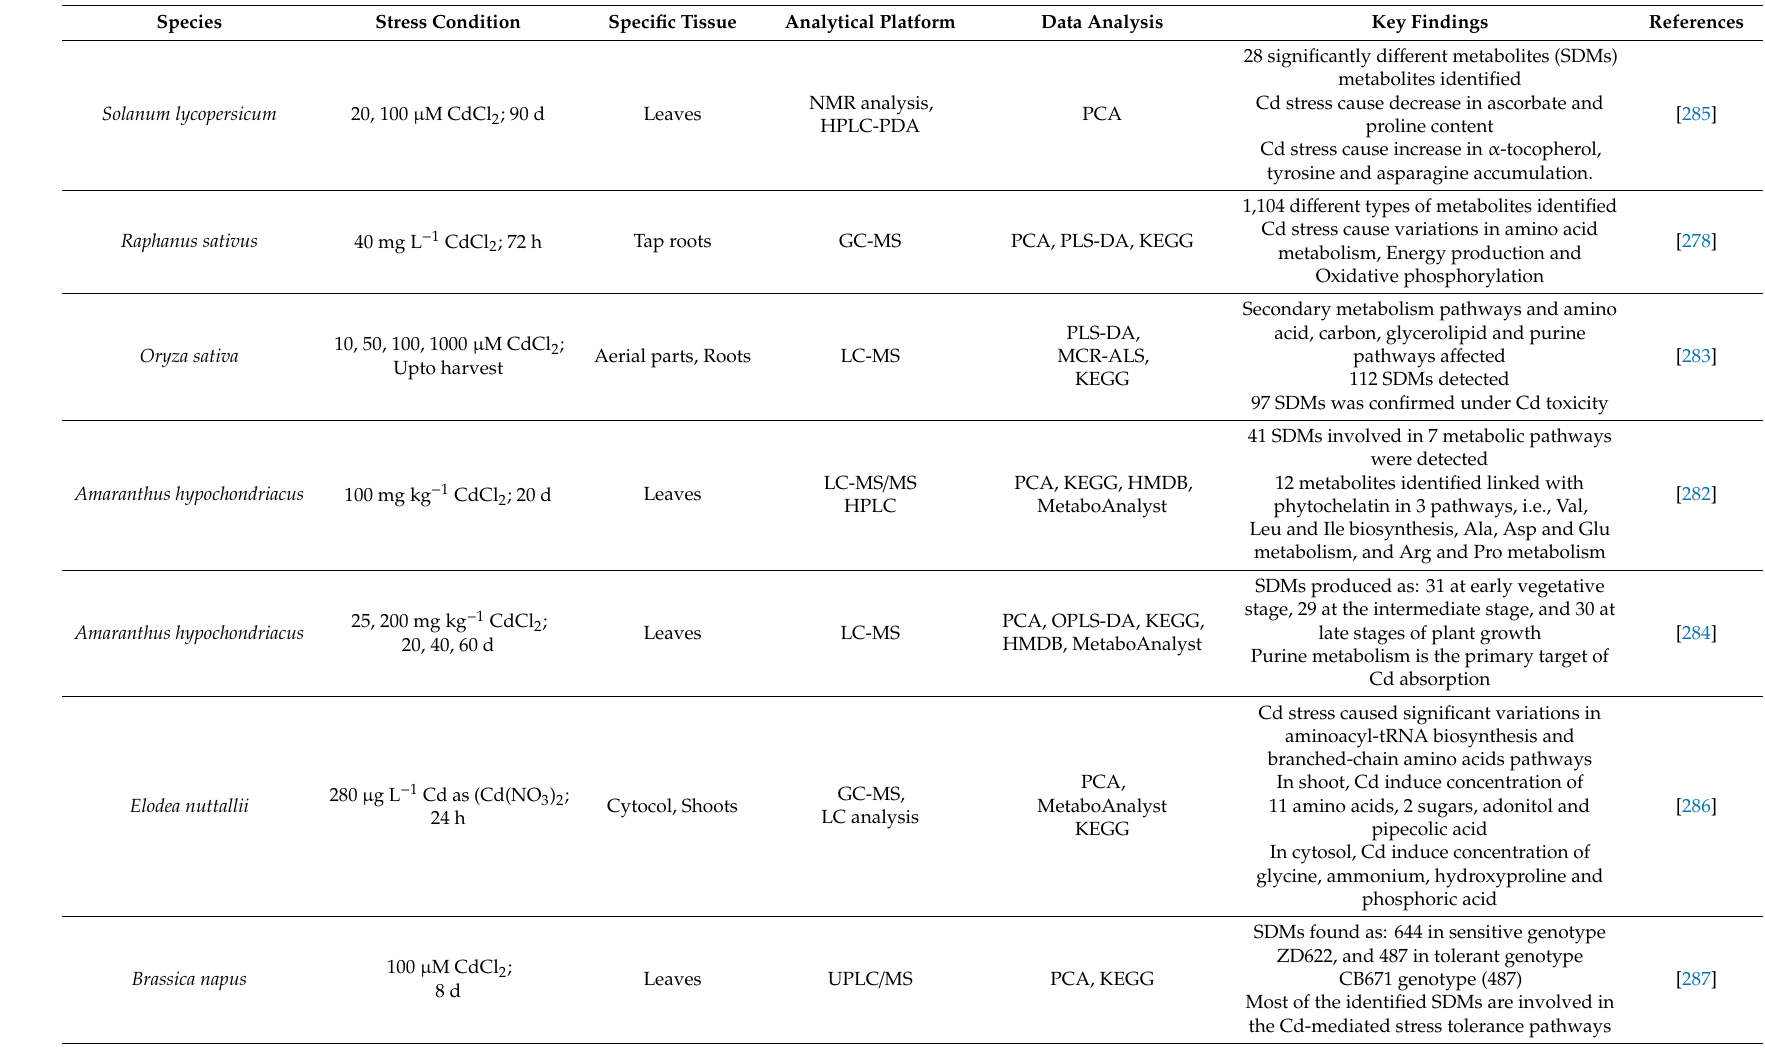
Table 6. Summary of experiments directing metabolomics profile under Cd stress in